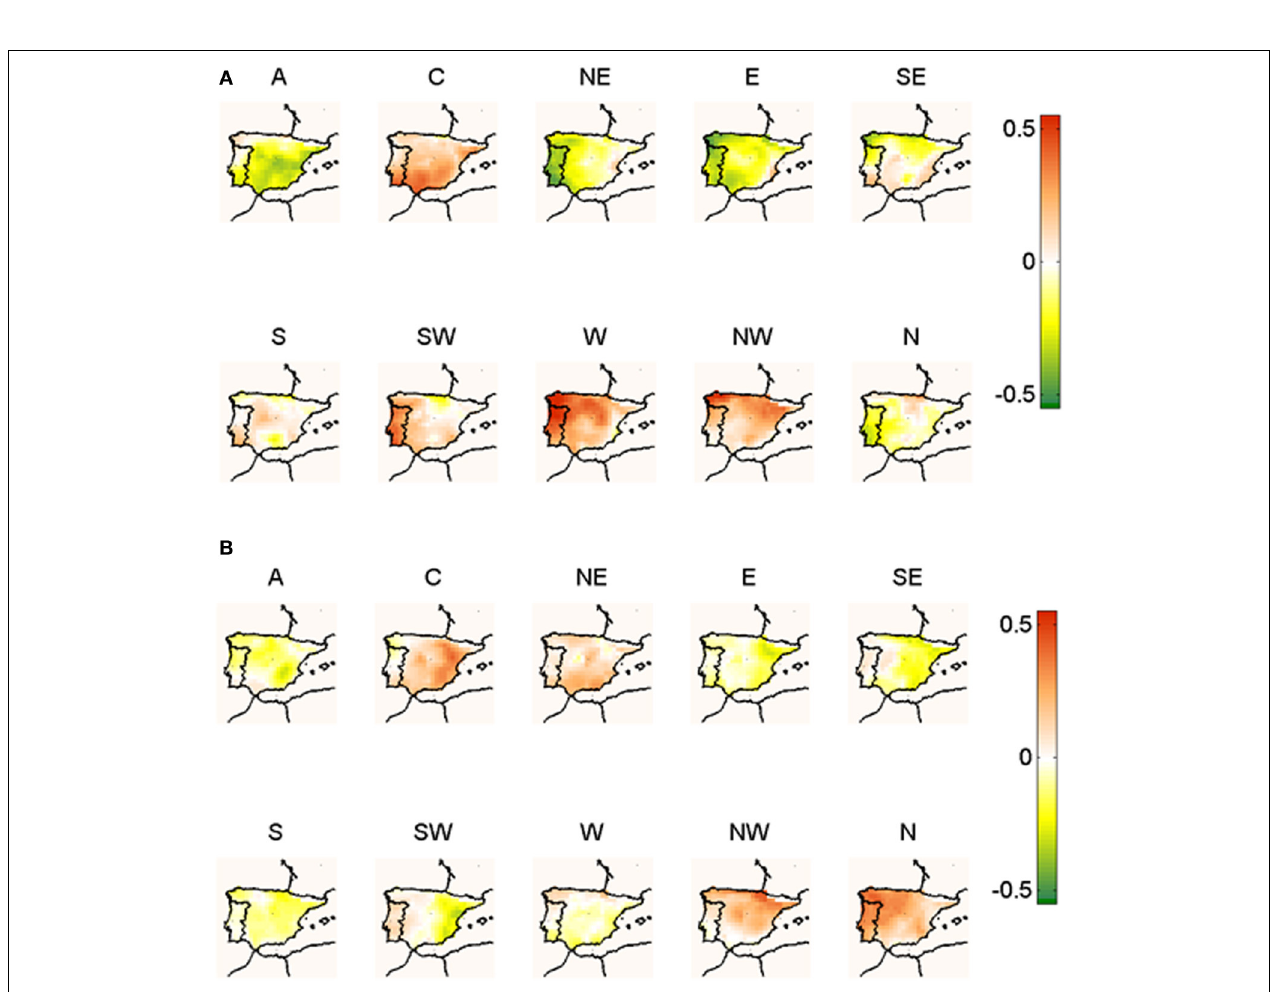
FIGURE 8 | Correlation between the (A) winter and (B) summer SPEI and the frequencies of each CWT. Significant correlations correspond to R -values higher than 0, 24 or lower than − 0,24 ( α < 0,05).